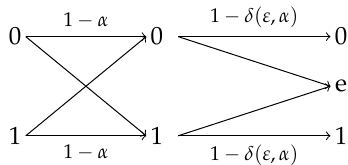
Figure 4. Optimal privacy filter for P Y | X = BSC ( α ) with uniform X where δ ( ε , α ) is specified in